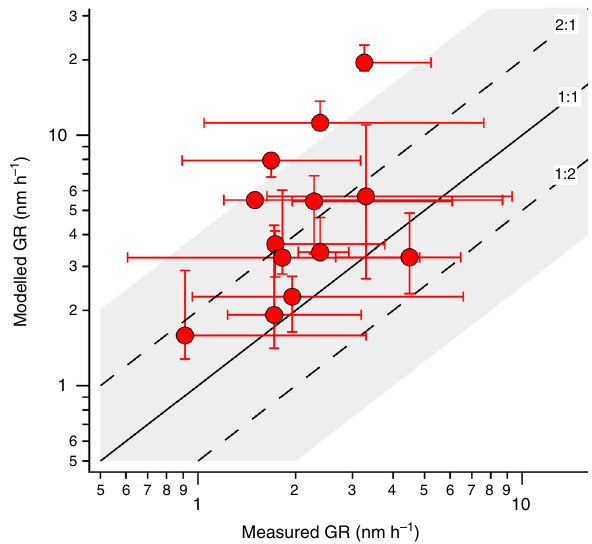
Measured GR (nm h –1 ) Fig. 3 Modeled vs measured growth rates (GR) for all 13 new particle formation events (3 – 30 nm). Modeled GR are calculated over the growth from 3 to 30 nm by a linear fi t to the diameter as a function of time. The error bars for the modeled GR represent the variation in GR if it is calculated as a fi t to different size ranges (3 – 5 nm, 5 – 10 nm, 10 – 20 nm, and 20 – 30 nm). The measured GR are calculated from particle size distributions by a linear fi t to the nucleation mode peak diameter as a function of time. The error bars for the measured GR represent the variation in the growth rate when the linear fi t is performed on mode peak diameters from different time intervals of the observed nanoparticle